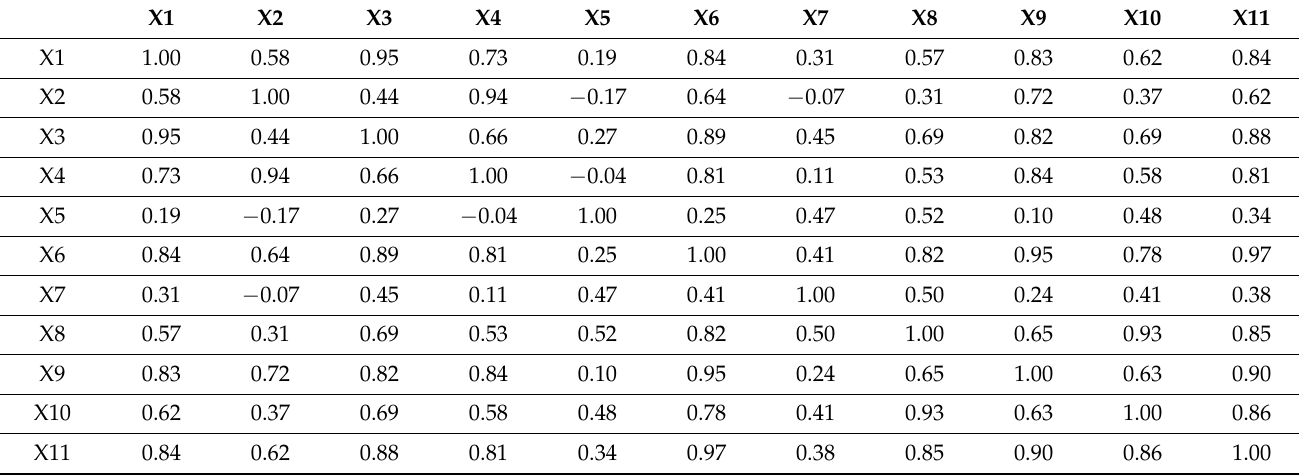
Table 5. Correlation matrix for 2008.